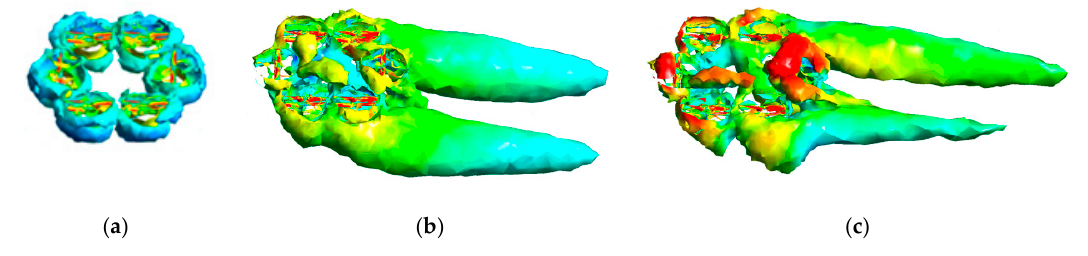
Figure 13. Vortices distribution: ( a ) 0 m/s; ( b ) 2.5 m/s; ( c ) 4.0 m/s.